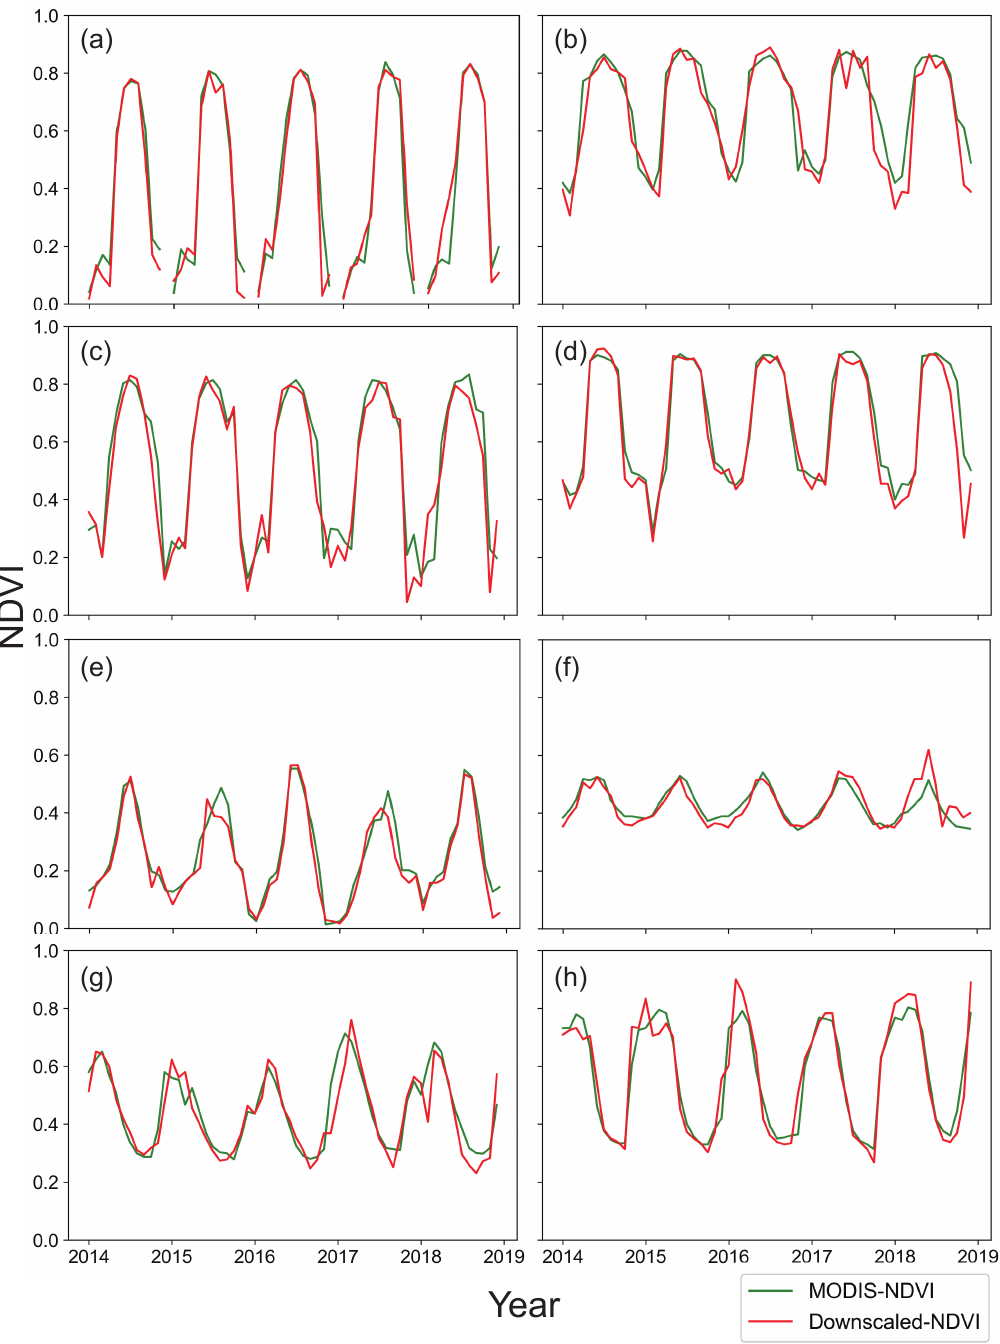
Figure 7. The long-term dynamic changes comparison between the downscaled and MODIS NDVI for different vegetation types. Comparison of NDVI for ( a ) Siberian Evergreen Needleleaf Forests, ( b ) Asian Evergreen Broadleaf Forests, ( c ) North American Evergreen Needleleaf Forests, ( d ) North American Deciduous Broadleaf Forests, ( e ) Mongolian Steppe, ( f ) Australian Savanna, ( g ) African Shrub, ( h ) South American Tropical